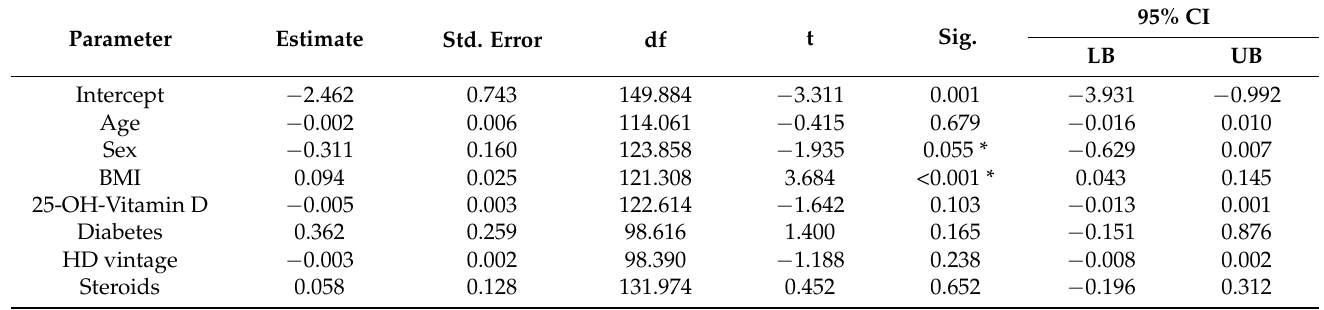
Table 6. Mixed model effect of inactive vitamin D on Z-score in kidney transplant patients at lumbar vertebral